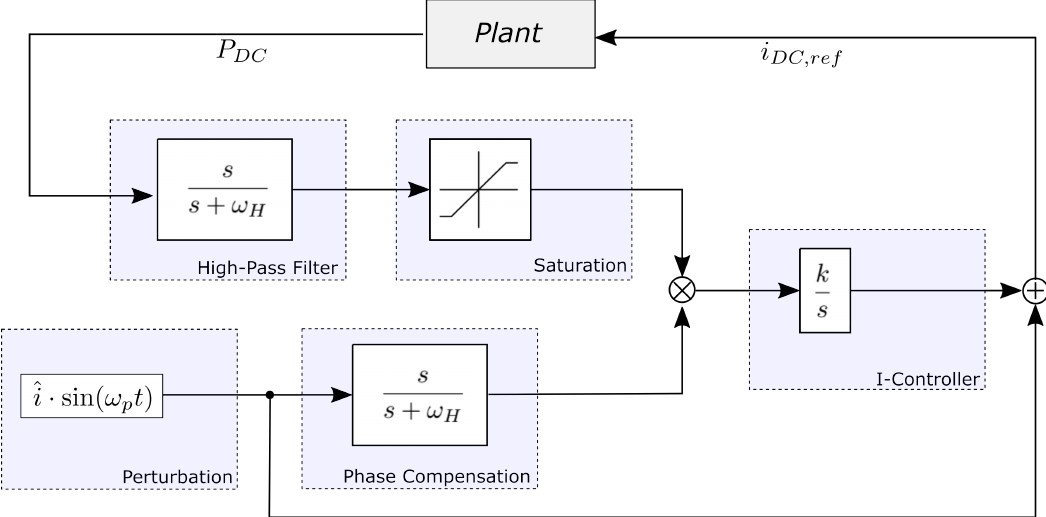
Figure 3. Extremum seeking control scheme. The generated power P DC is probed by the introduced harmonic perturbation. The response’s gradient is retrieved using a high-pass filter, evaluated considering a phase shift, and controlled to